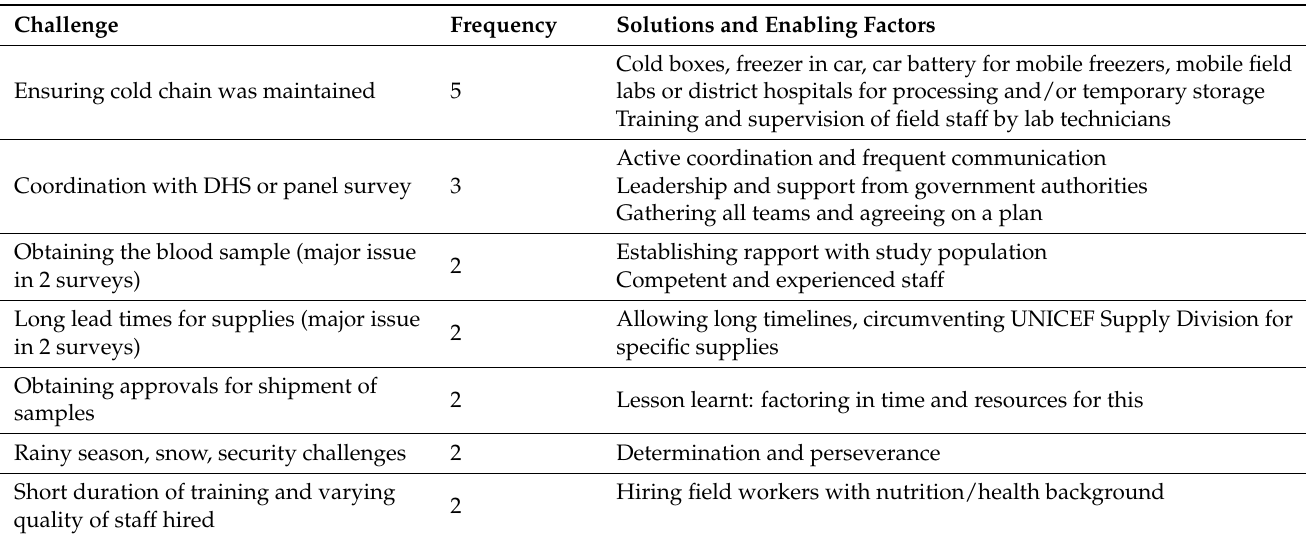
Table 4. Main challenges faced during collection, processing, transport, and storage of blood and urine